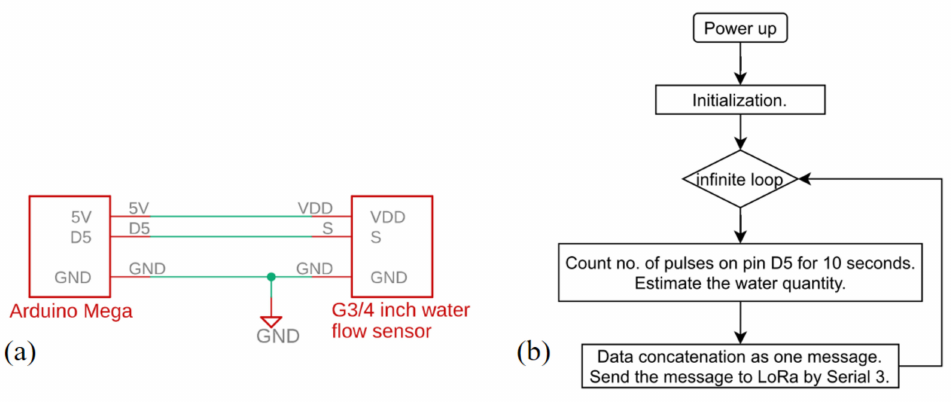
Figure 6. ( a ) A partial schematic and ( b ) the program flowchart for the type D